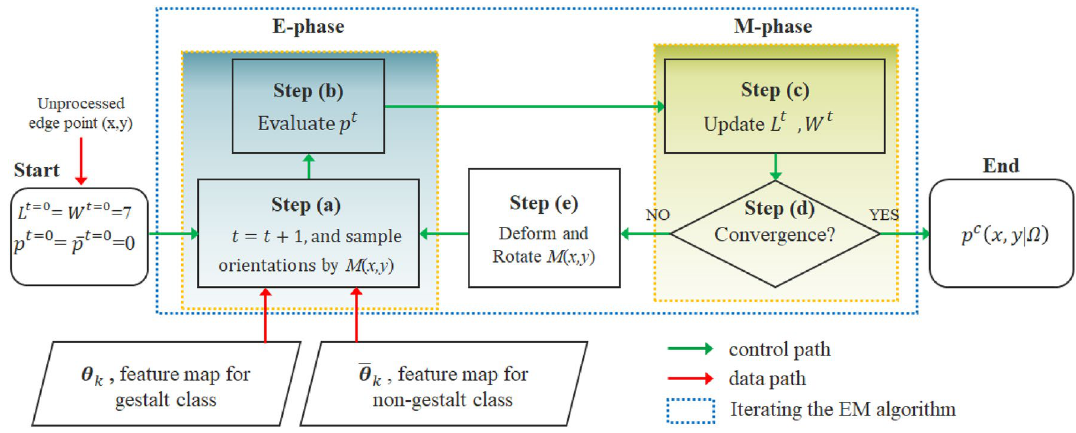
Figure 4. Flowchart of computing likelihood values for a target edge